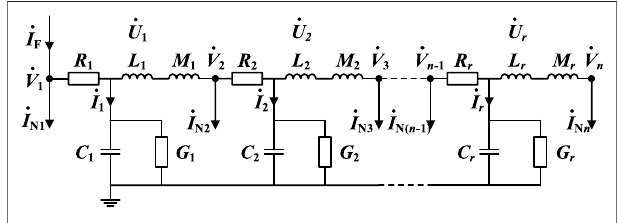
FIGURE 1 | Equivalent electrical network model of grounding